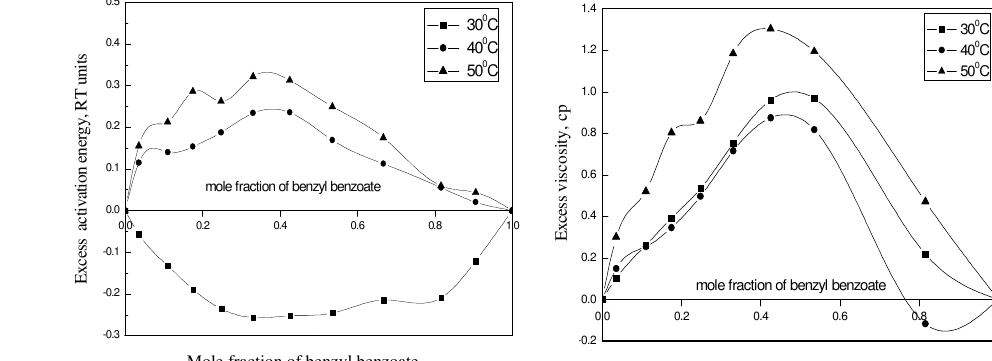
Mole fraction of benzyl benzoate